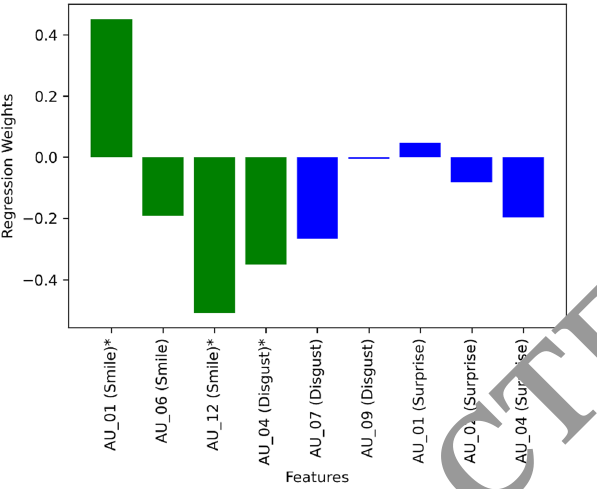
Fig. 3 Sample frames from the data set. All participants made three facial expressions followed by a neutral